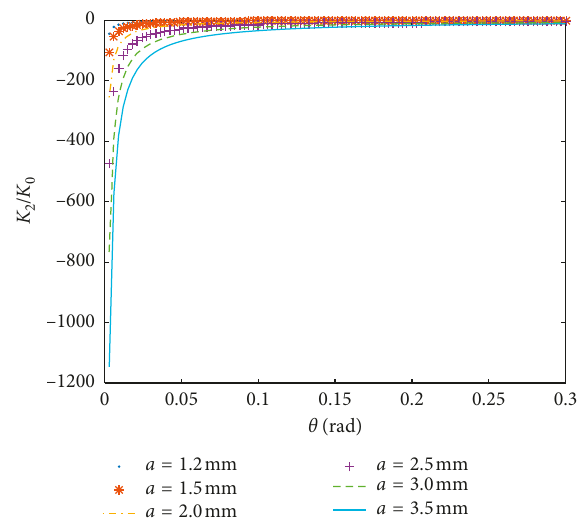
Figure 13: Relationship between IFs K values of the crack length a .